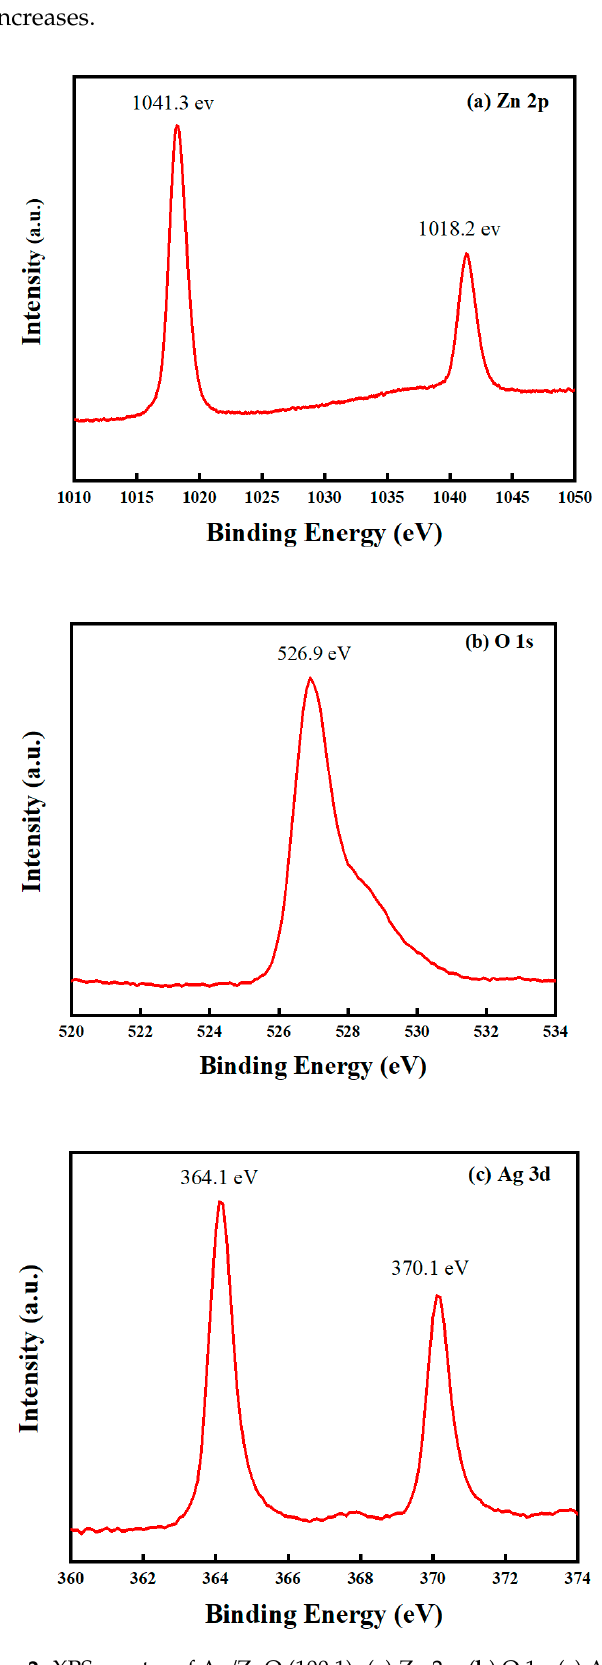
Figure 2. XPS spectra of Ag / ZnO (100:1). ( a ) Zn 2p, ( b ) O 1s, ( c ) Ag 3d.